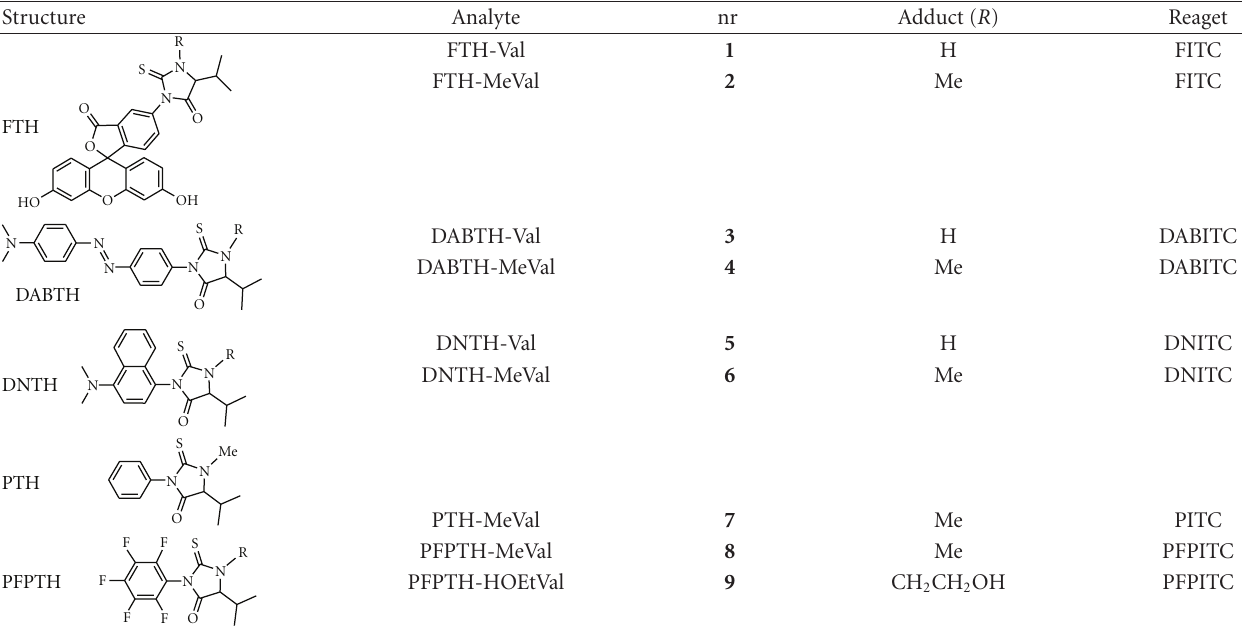
Table 1: Studied thiohydantoin analytes by LC/MS/MS.